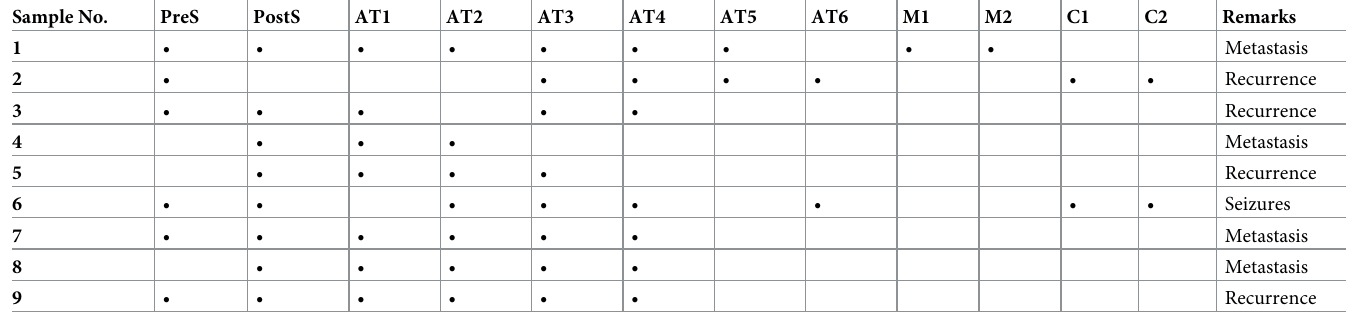
Table 2. Patient treatment history. Sample